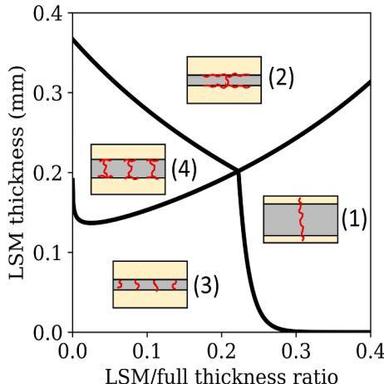
Damage mode map for 3D printed hybrid carbon-fibreglass composite. The numerals refer to the damage modes: (1) HSM failure, (2) Catastrophic delamination & HSM failure, (3) LSM fragmentation & HSM failure, and (4) LSM fragmentation, diffuse delamination & HSM. (For interpretation of the references to colour in this figure legend, the reader is referred to the web version of this article.)